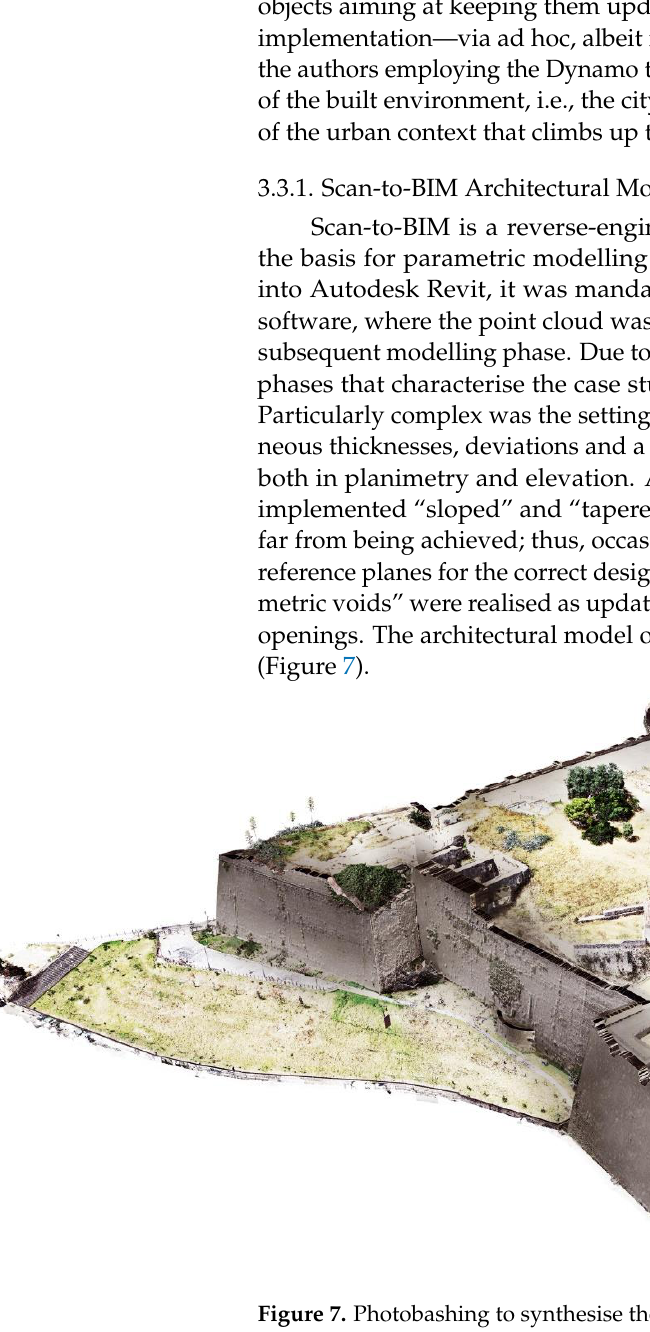
Figure 7. Photobashing to synthesise the Scan-to-HBIM process.